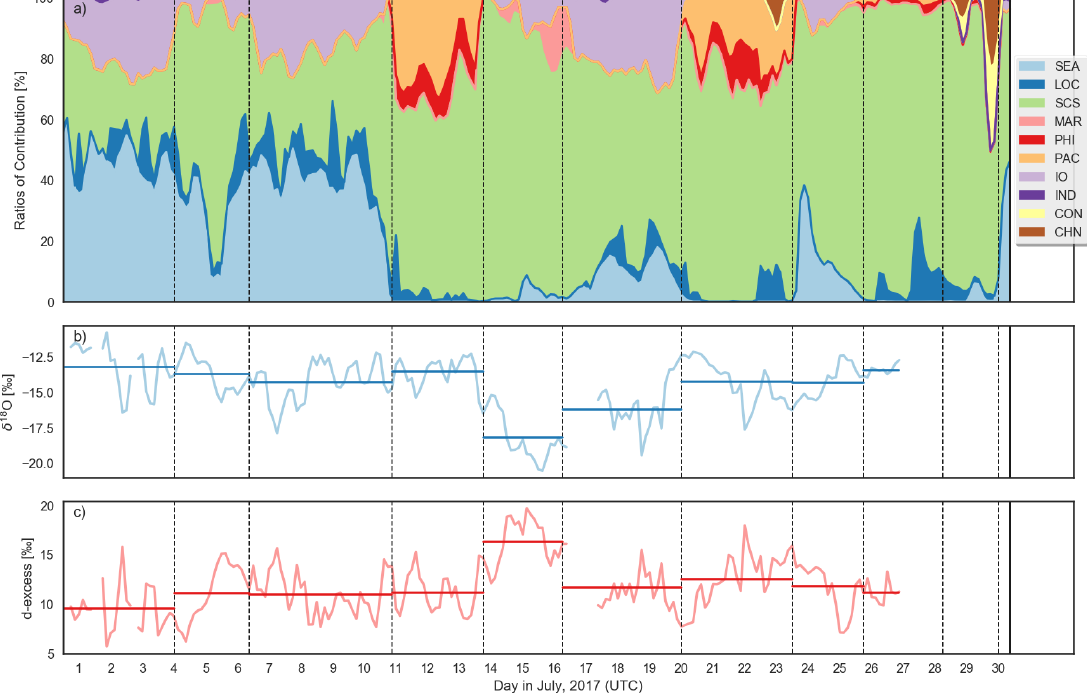
Figure 11. Time evolution during July 2017 of ( a ) relative moisture source ratios for each region reconstructed using the FLEXPART model, ( b ) observed values of δ 18 O in water vapor at the Gaoqiao mangrove observation site, and ( c ) observed values of d-excess in water vapor at the same